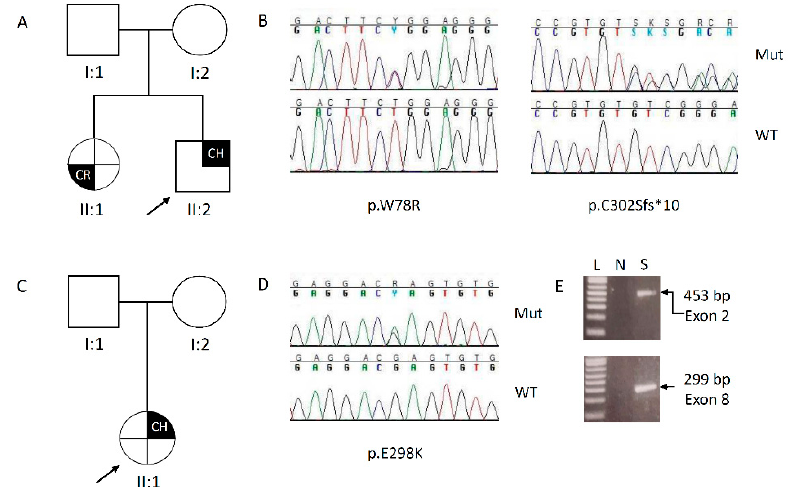
Figure 2. ( A – C ): Pedigree of the families under study. The arrow indicates the proband; ( B – D ): elechropherograms showing the pathogenic variants identified. For each case, on the top the mutated sequence, on the bottom the wild type; CH: chronic hypoparathyroidism; CR: cutaneous rush; L = ladder; N = negative PCR reaction; S =